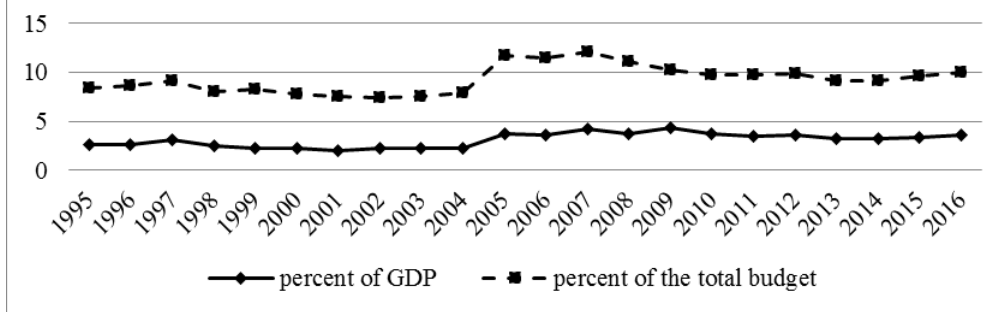
Figure 2. Expenditures of the budget system of the Russian Federation on the health care system (consolidated budget of the Russian Federation and budgets of state extra-budgetary funds). Note: Since 2005, data on the consolidated budget of the Russian Federation are provided taking into account the budgets of state extra-budgetary funds. From 1995 to 2010, the cost of physical culture is taken into account. Since 2011, only expenditure on healthcare has been presented. Budgets of state extra-budgetary funds include compulsory health insurance. Thus, the compulsory insurance contributions of all Russian employers are also included in the official statistical report of public expenditure on health.